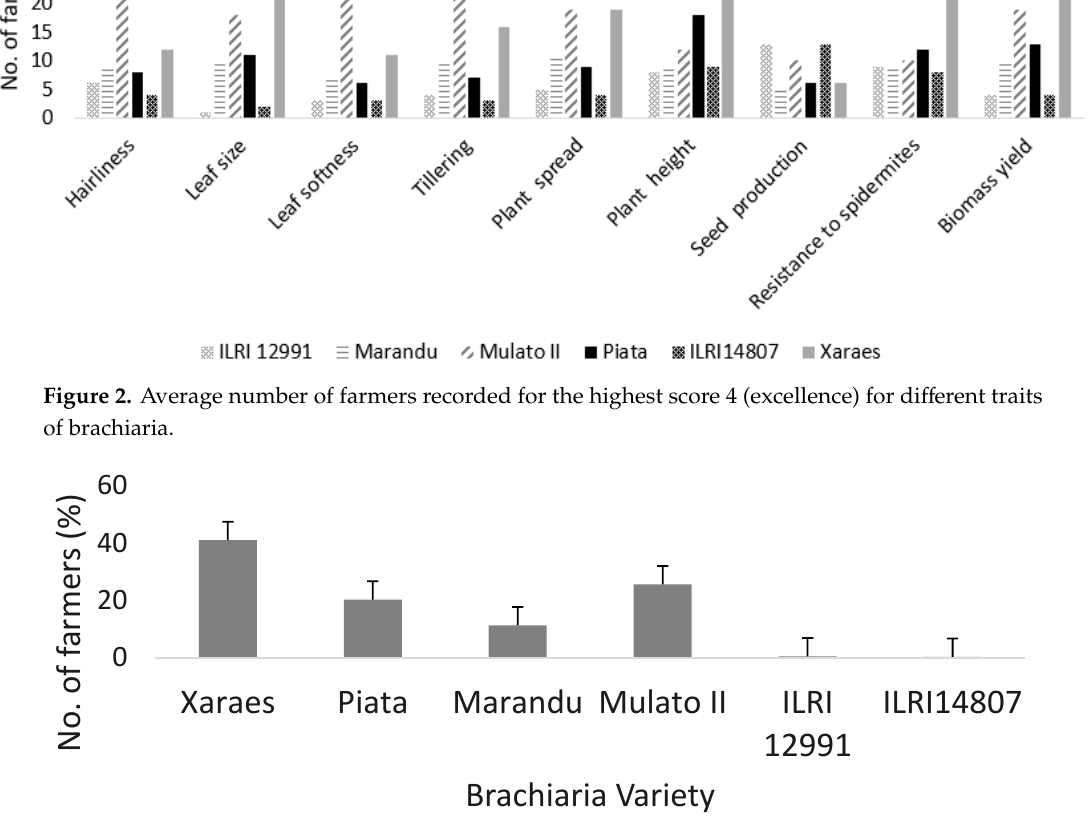
Figure 3. Means for number of farmers (%) for each brachiaria genotype across all the districts. Bars represent standard error of the means.